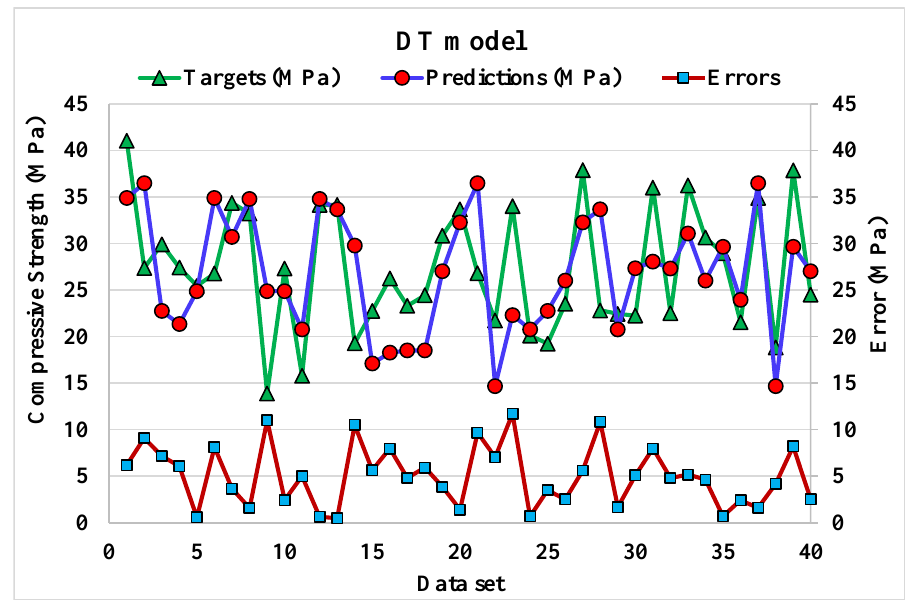
Figure 11. Dispersion of predicted and actual values along with errors for DT model.